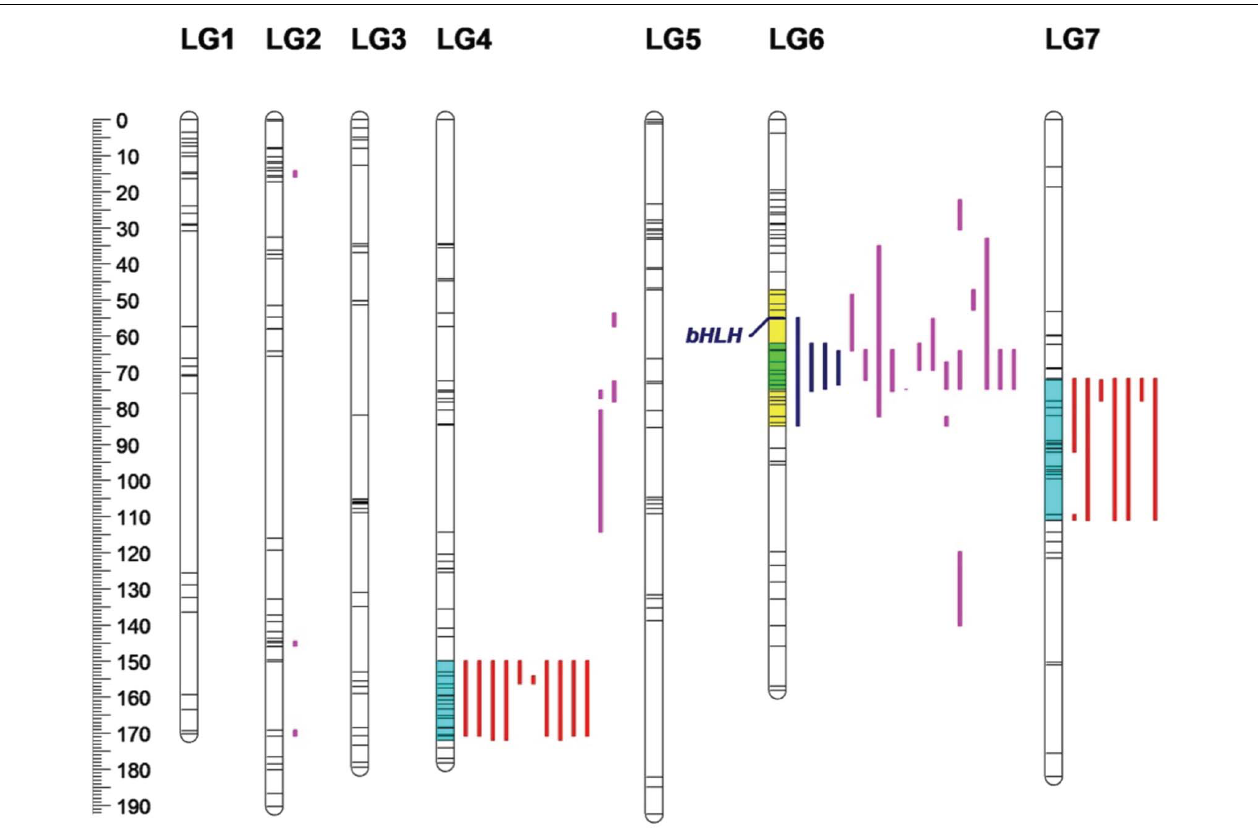
FIGURE 6 | Locations of pigment content QTLs on the genetic linkage map of the rose YS population. Blue lines represent QTL regions associated with anthocyanin content; purple lines represent QTL regions associated with flavonol content, and red lines represent for QTL regions associated with carotenoid